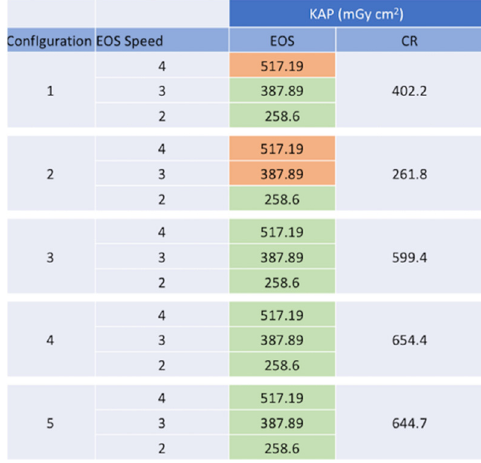
Figure 3. Radiation doses delivered by the EOS-Fast (speed 2), EOS-Medium (speed 3), and EOS-Slow (speed 4) protocols, and CR examinations. Appl. Sci. 2020 , 10 , x FOR PEER REVIEW